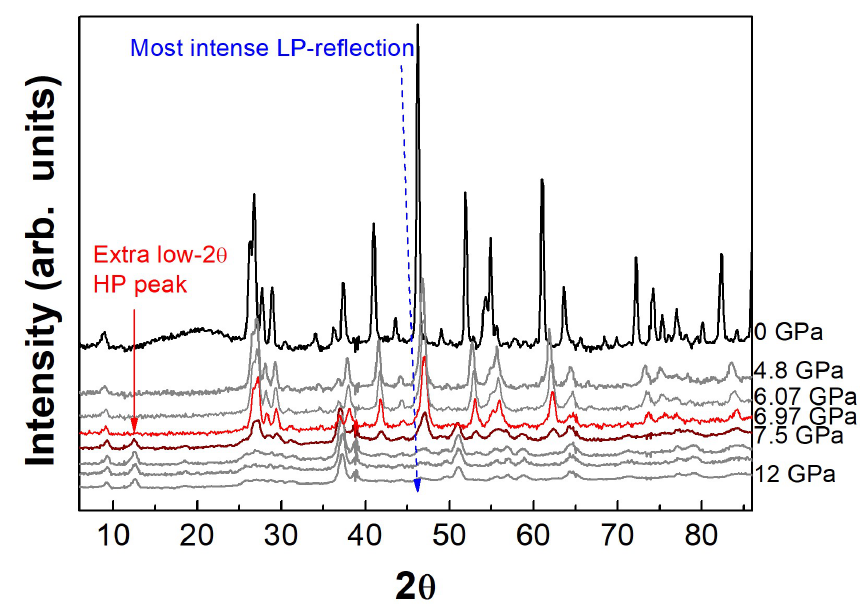
Figure 10. Pressure dependence of the ND data. Note the appropriate hydrostatic conditions which are confirmed by the presence of the diffuse scattering from the ethanol-methanol pressure transmitting medium close to 20° at 0 GPa. The M2 high-pressure phase is also characterized by the extra low 2θ peak arising from antiferromagnetic ordering.